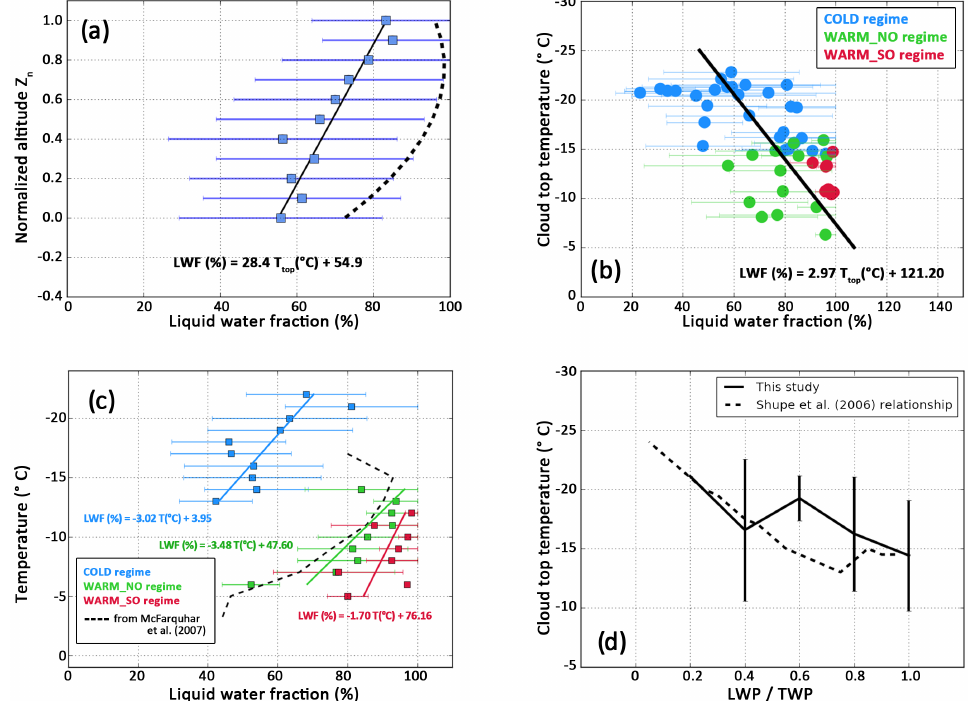
Figure 10. Liquid water fraction according to Z n (a) , cloud top temperature (b) and temperature (c) . The dotted dashed line in panels (a) and (c) is the parameterization from McFarquhar et al. (2007) and the solid lines in panels (a) , (b) and (c) are the fittings for the present study. (d) Ratio of LWP over total water path (TWP) according to cloud top temperature. The solid line refers to the present study and the dotted line refers to Shupe et al.